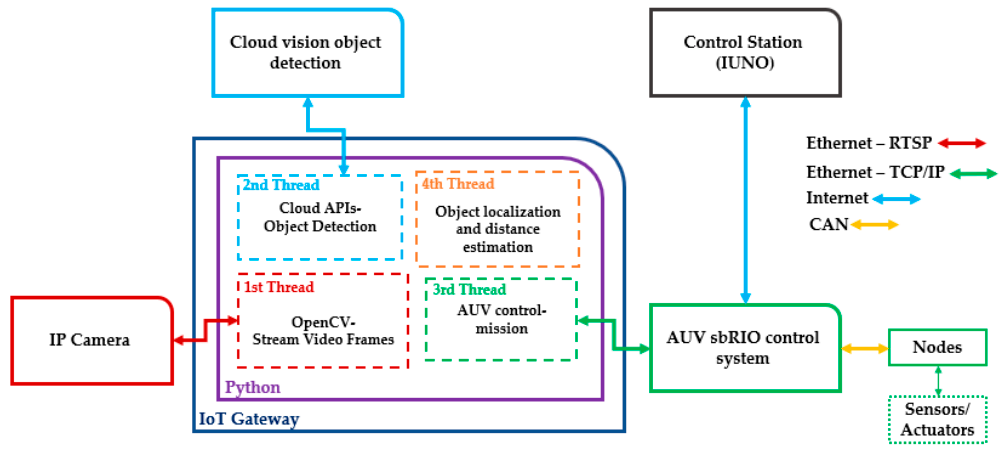
Figure 4. Node intercommunications and concurrent threads in the IoT gateway.